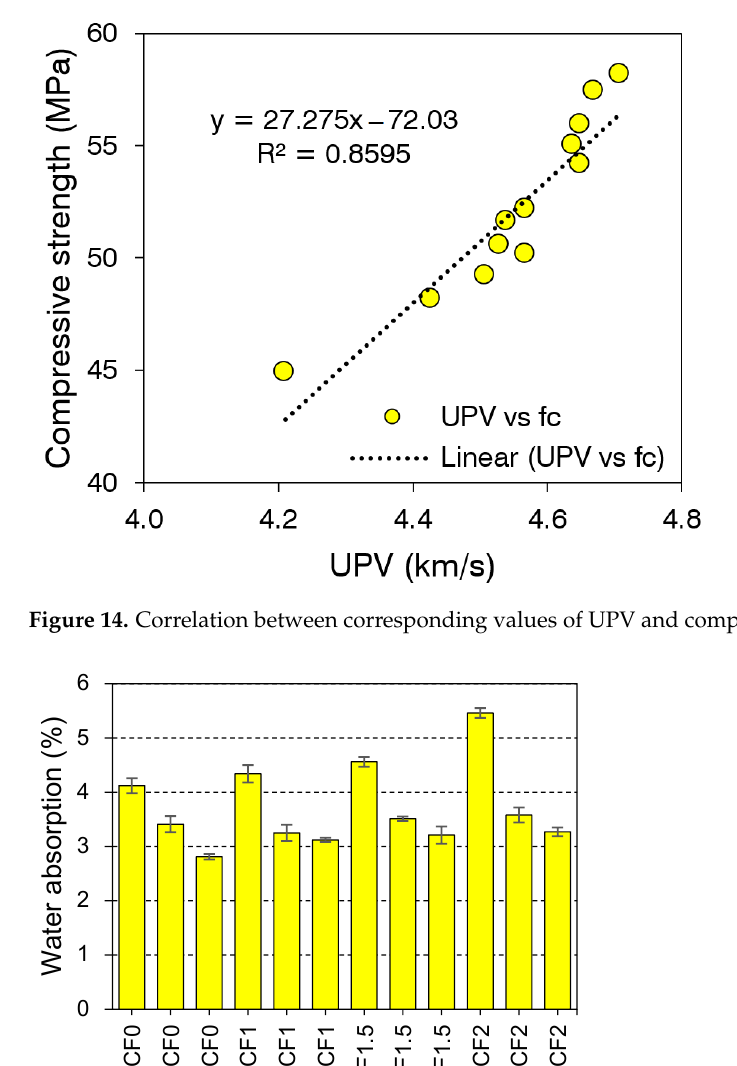
Figure 13. Effect of silica fume and coir reinforcement on the ultrasonic pulse velocity (UPV) of HSC.